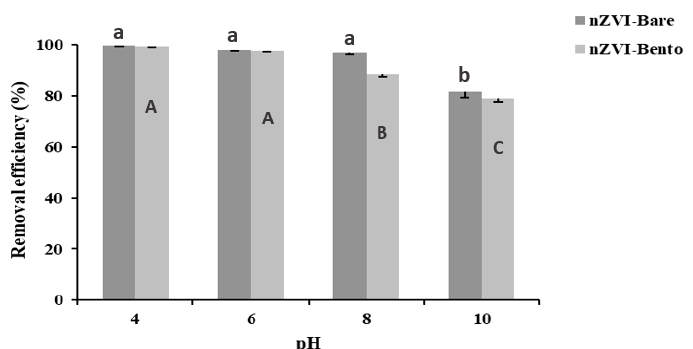
Figure 5. Effect of pH on arsenate (As (V)) removal (%) by nano ZVI products (adsorbent dose = 0.25 g L − 1 ) from arsenic-contaminated water ( C 0 = 5 mg L —1 ). Different lowercase letters denote a significant difference among the values across the treatments in nZVI-Bare, while different uppercase letters denote significant difference for nZVI-Bento treatments.